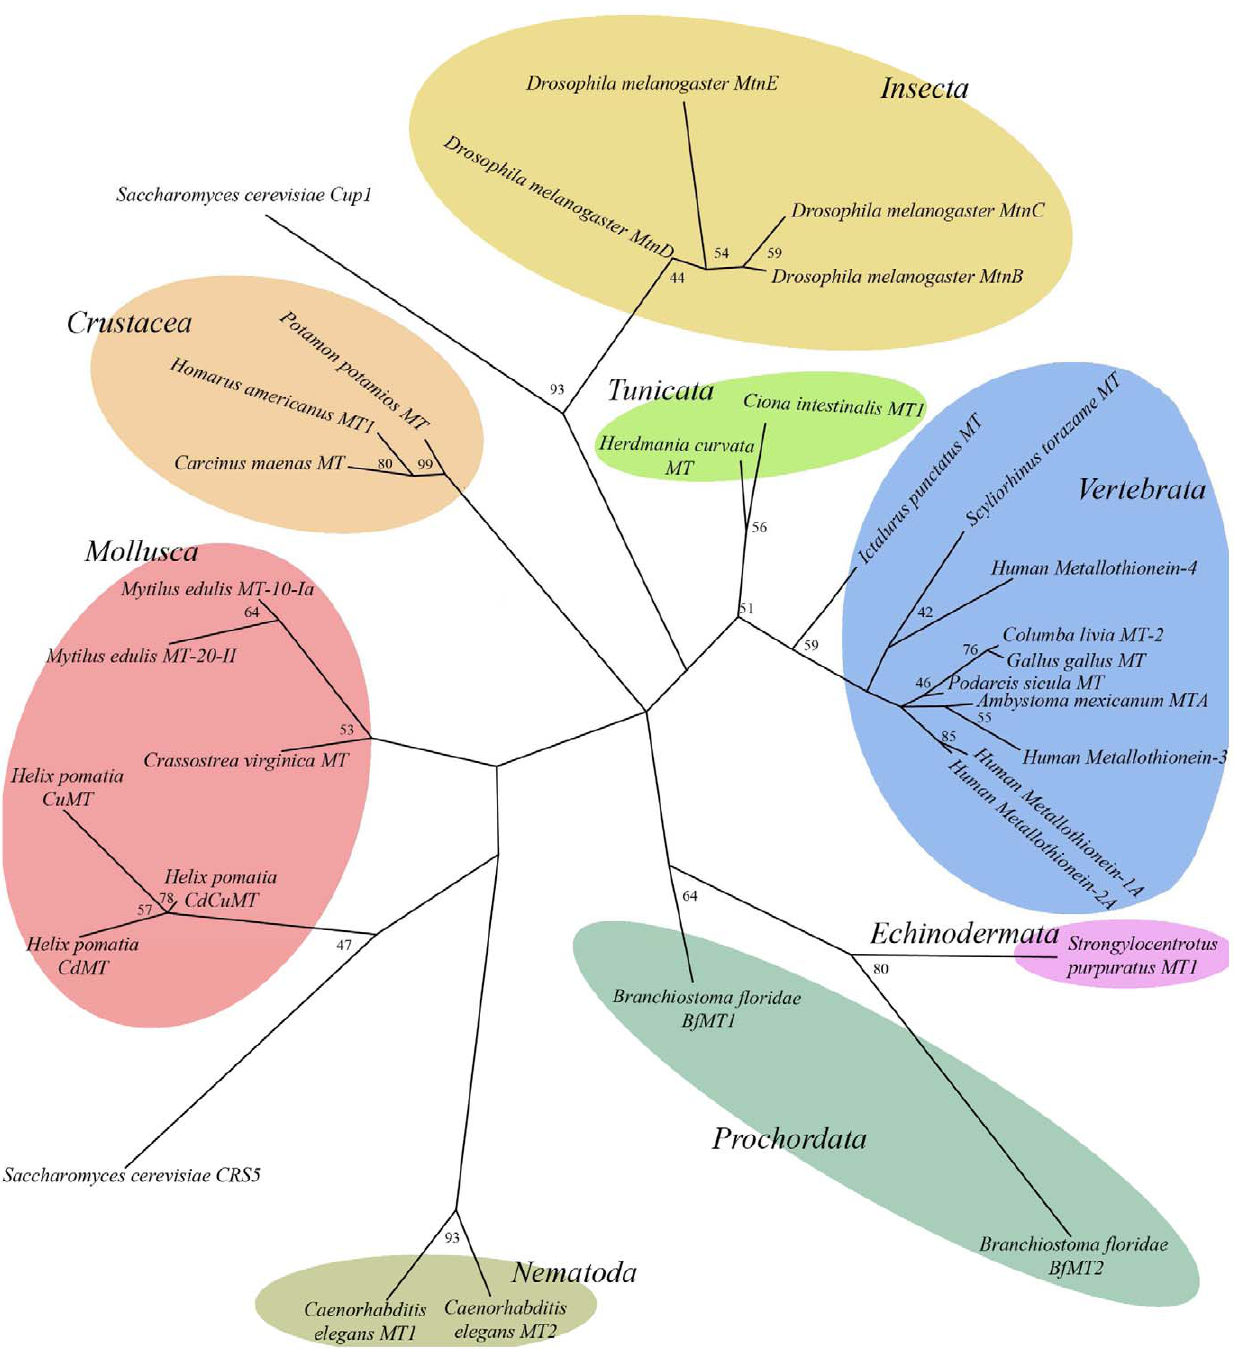
Figure 11. Protein distance analysis of MTs from organisms of different taxa positions Branchiostoma MTs at the base of vertebrates and close to Echinoderm MTs. The Maximum Likelihood tree was obtained by the Phylip method, and the corresponding bootstrap values (in percentages) obtained are included. Sequences and their Uniprot IDs are: Human MT-1A (P04731), Human MT-2A (P02795), Human MT-3 (P25713), Human MT-4 (P47944), Gallus gallus MT (P68497), Columba livia MT-2 (P15787), Podarcis sicula MT (Q708T3), Ictalurus punctatus MT (O93571), Scyliorhinus torazame MT (Q6J1T3), Ambystoma mexicanum MTA (O42152), Mytilus edulis 10 Ia (P80246), Crassostrea virginica MT (P23038), Mytilus edulis MT-20-II (P80252), Helix pomatia CdCuMT (D1LZJ8), Helix pomatia CdMT (P33187), Helix pomatia CuMT (P55947), Homarus americanus MT1 (P29499), Carcinus maenas MT (P55948), Potamon potamios MT (P55952), Drosophila melanogaster MtnB (P11956), Drosophila melanogaster MtnC (Q9VDN2), Drosophila melanogaster MtnD (Q8I9B4), Caenorhabditis elegans MT1 (P17511), Caenorhabditis elegans MT2 (P17512), Saccharomyces cerevisiae Cup1 (P0CX80), Saccharomyces cerevisiae CRS5 (P41902). The following sequences were obtained from GeneBank: Strongylocentrotus purpuratus MT1 (AAA30061.1), Ciona intestinalis MT1 (ACN32211.2), Herdmania curvata MT (AY314949.1). Drosophila melanogaster MtnE sequence was obtained from FlyBase (FlyBaseID: FBpp0293071).